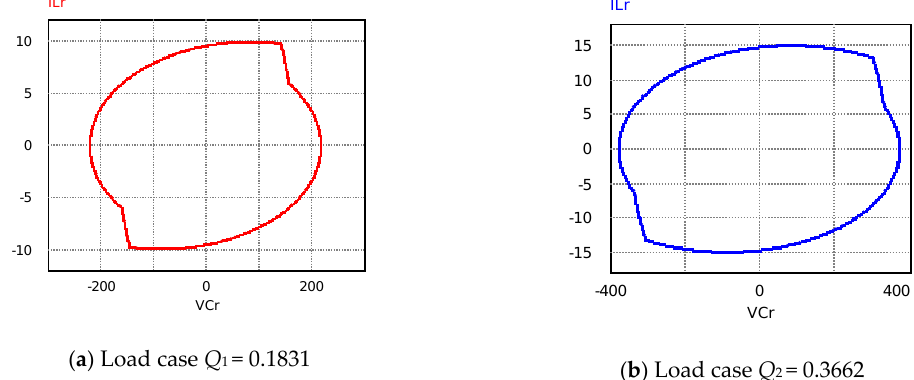
Figure 11. PSIM simulation results of the state-trajectories above resonant frequency.